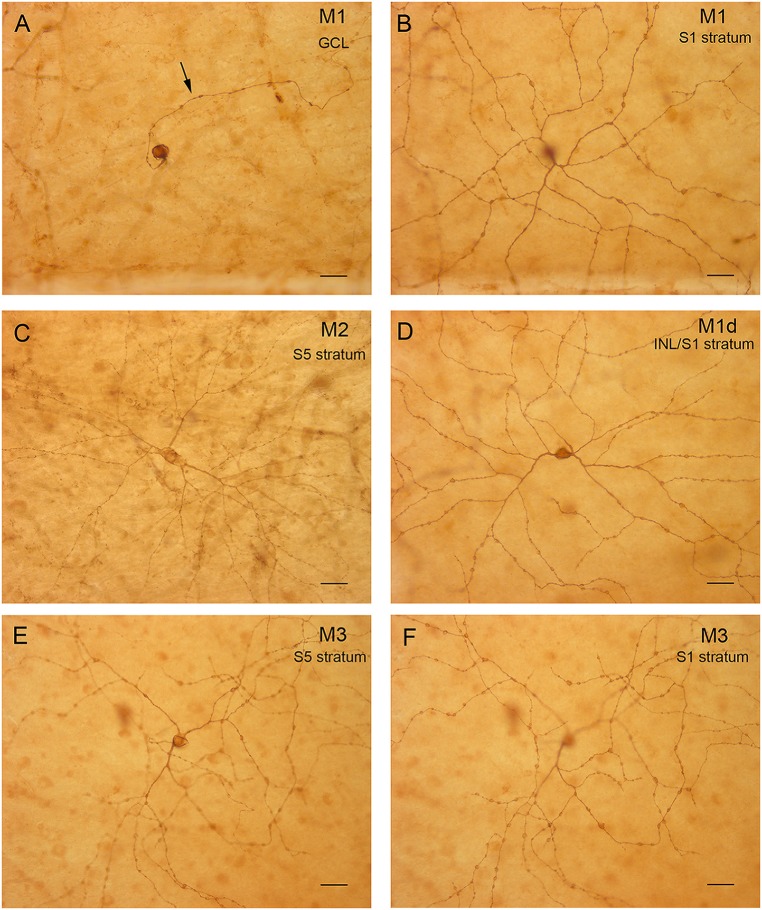
mRGC types in the human retina. (A,B) Representative M1 cell with the soma and axon (arrow) located in the GCL (A) and dendrites in the stratum S1 of the IPL (B). (C) M2 cell with the cell body located in the GCL and dendrites in S5 of the IPL. (D) Displaced M1 cell (M1d) with the body located in the INL and dendrites in the stratum S1 of the IPL. (E,F) M3 cell with the cell body located in the GCL (E) and dendrites in both S5 (E) and S1 of the IPL (F). Scale bar: 40 μm.